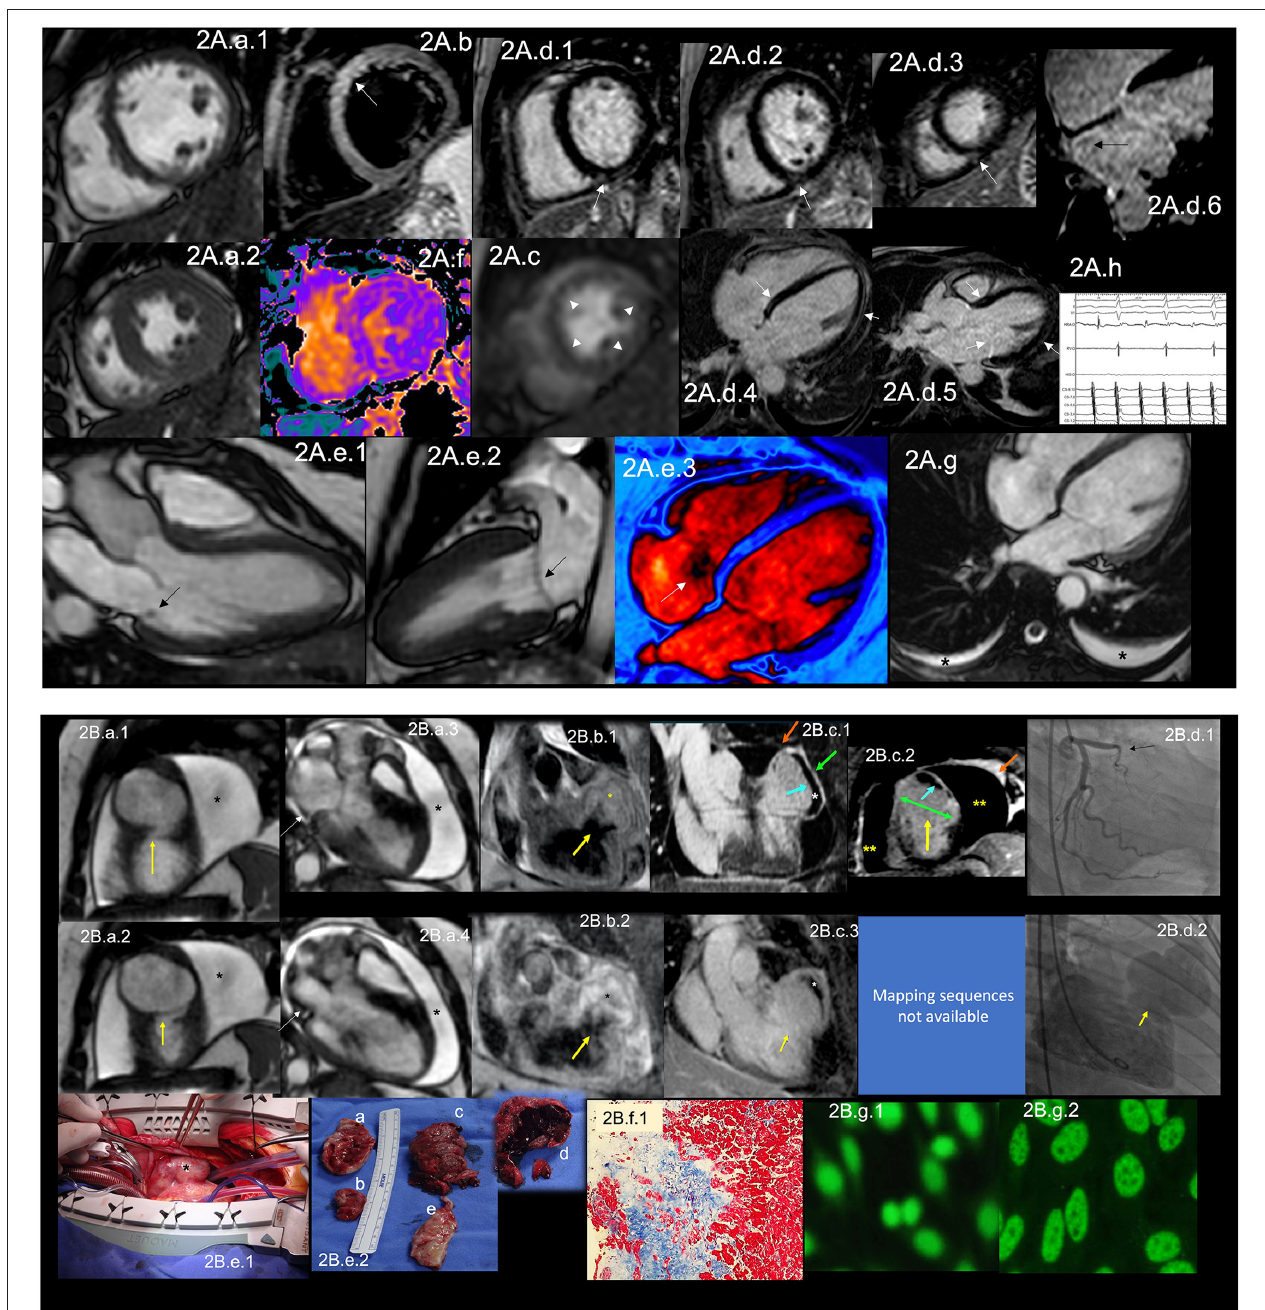
FIGURE 2 | (A) CMR findings in SLE— (A) from an arrhythmic perspective. A panel figure demonstrates the array of findings from a comprehensive CMR study in SLE from an arrhythmia perspective. (A.a) Shows normal global and regional right and left ventricular functions in SSFP sequence still cine images in short-axis views at the mid-ventricular level in end-diastole (A.a.1) and end-systole (A.a.2) LVEF 66% and RVEF 63%. (A.b) T2-W STIR sequence in short-axis view projection at a mid-ventricular level demonstrating mildly increased signal intensity in the anterior, anteroseptal, and inferoseptal segments (arrow) with a myocardial/skeletal muscle ratio of 2.8 and (A.f) a color-coded T2 mapping (native T2 value of 48ms) consistent with myocardial edema. (A.c) Stress CMR with FPP T1-W sequence with adenosine infusion at 140 mcg/kg/min over 6 minutes shows a subendocardial ring perfusion defect (arrowheads) consistent with subendocardial ischemia due to endothelial dysfunction and probably microvascular disease (no obstructive coronary artery disease in CCTA). (A.d.1) LGE PSIR sequence. (A.d.1–3) short-axis views at basal (A.d.1), mid (A.d.2) and apical (A.d.3) levels, and long-axis views in 4-chambers (A.d.4,6) and 3-chambers (A.d.5) projections. The arrows in these images show areas of focal fibrosis in the subepicardium in the inferior segments in (A.d.1–3) from the base to the apex. (A.d.4,5) shows areas of midventricular LGE in basal anteroseptal and inferoseptal segments (arrows) and subepicardial enhancement in mid and apical inferolateral segments (arrow). (A.d.6) A zoomed image of the 4-chambers view showing LGE suggestive of LA fibrosis (arrow). (A.h) A polygraphic trace of an EP study showing atrial fibrillation successfully ablated.